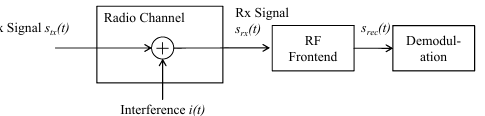
Figure 4. Interference